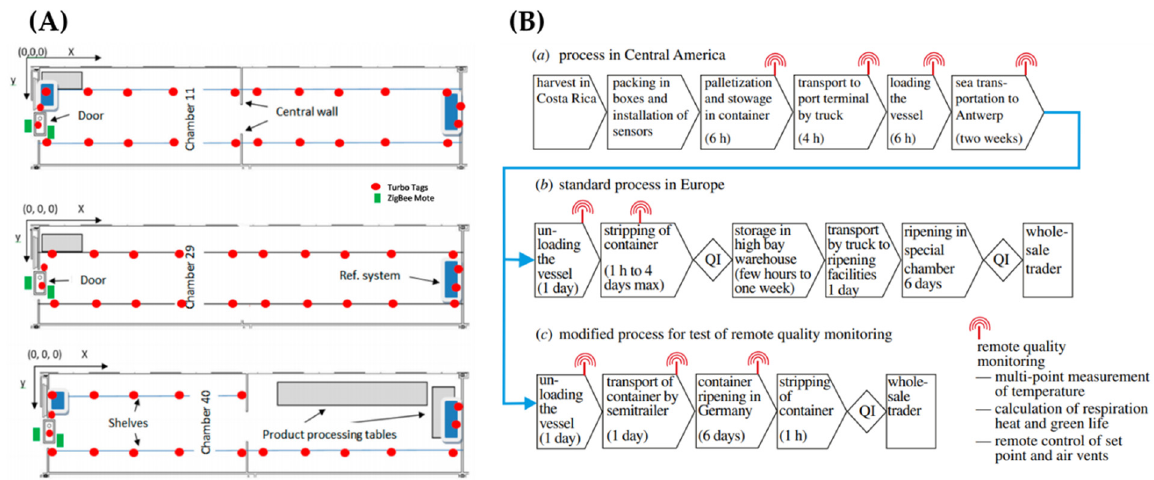
Figure 9. ( A ) Schematic diagram of the cold rooms and sensor distribution [81]. ( B ) Simplified structure of the cold chain for bananas, from harvest to ripening by ethylene treatment, with regular duration of steps, reproduced from [85].